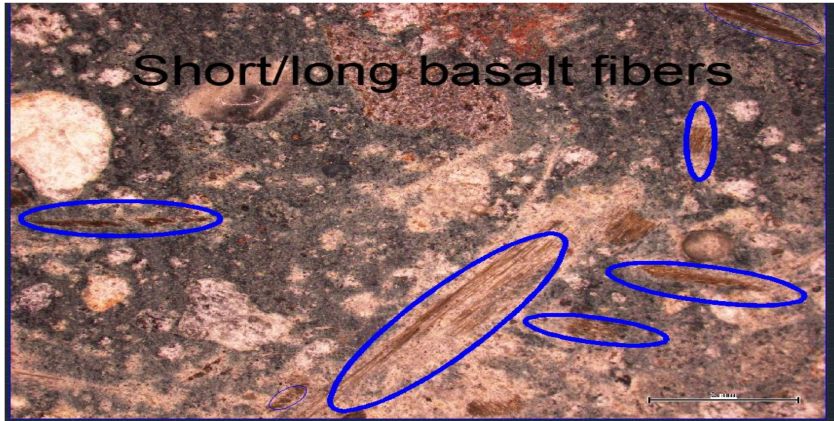
Figure 15. Optical microscope image of hybrid basalt fibres reinforced SCGC.